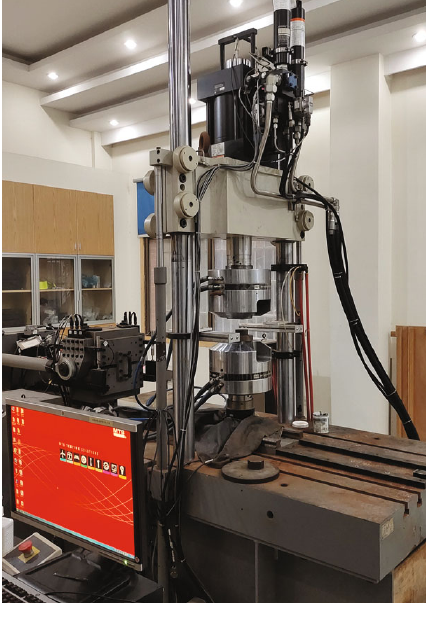
Figure 3: Photographic view of the loading